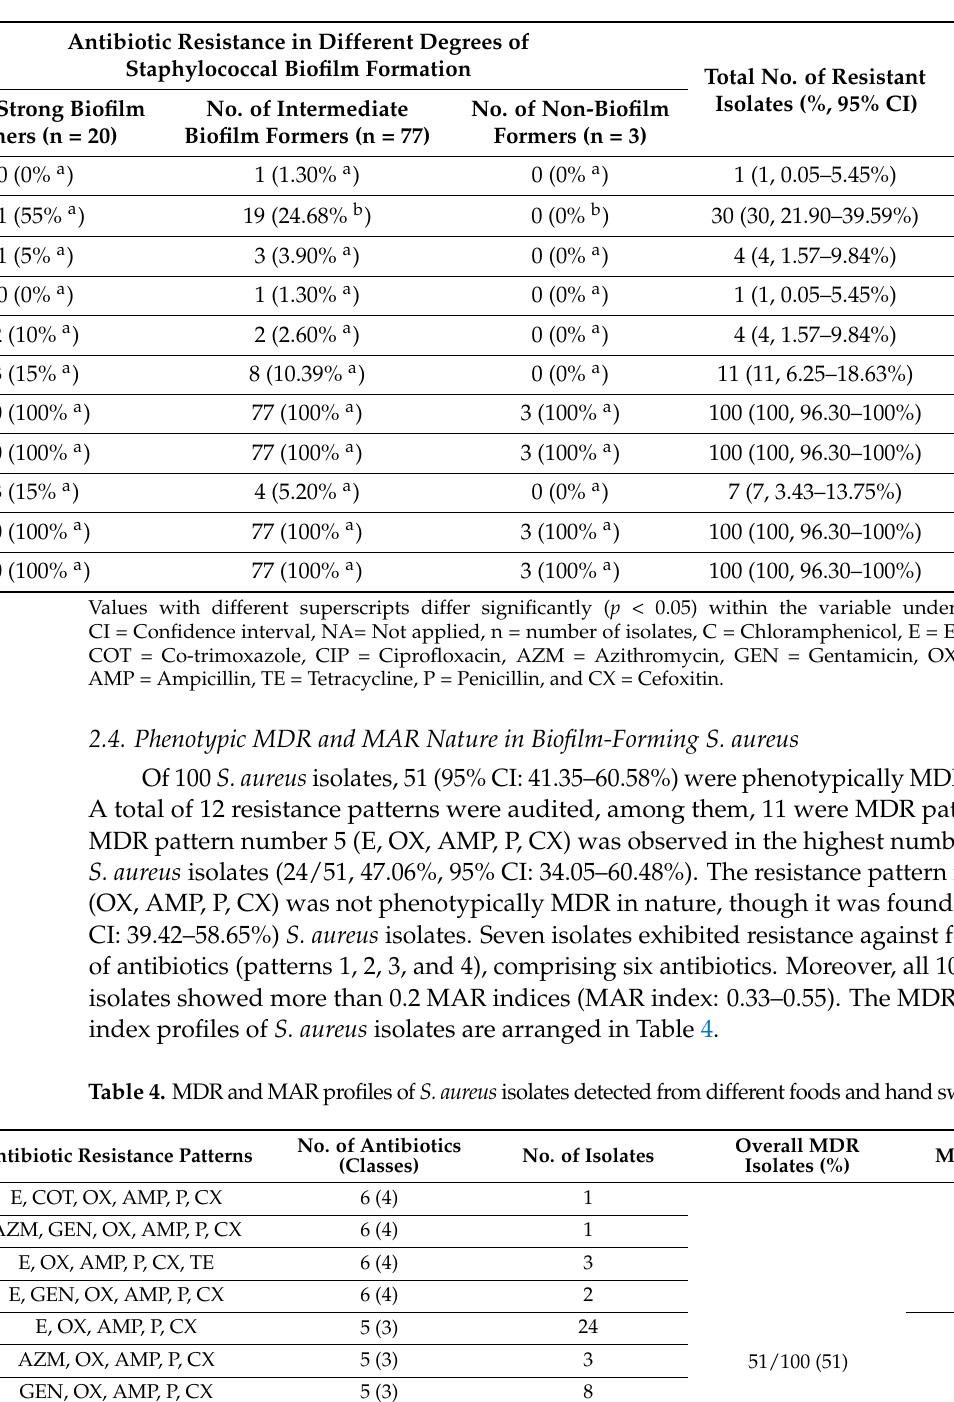
Table 3. Association of antibiotic resistance patterns and biofilm formation in S. aureus strains detected in different food and hand swab samples.